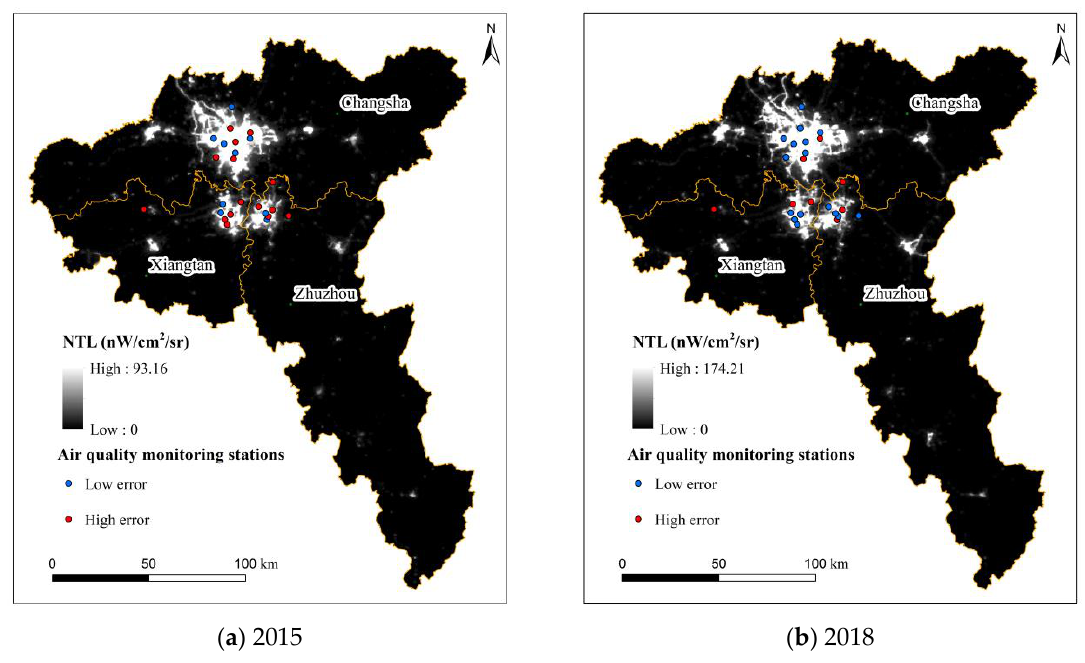
Figure 8. Spatial distribution of low and high-error stations.